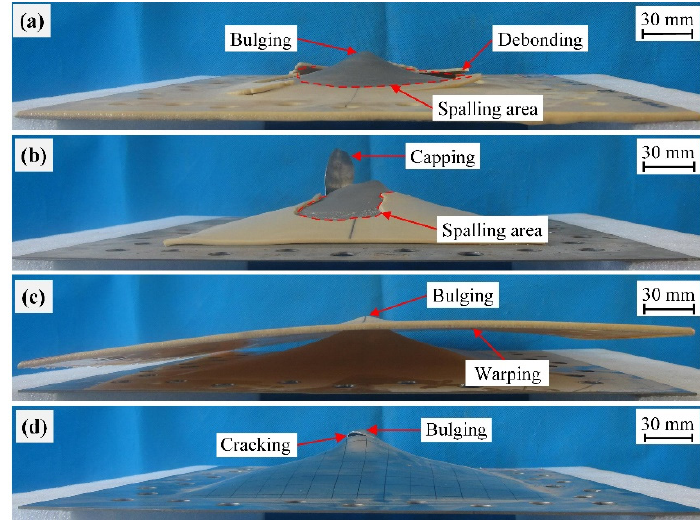
Figure 7. Photographs of the damaged plates ( a ) SPW-2, ( b ) SPP-2, ( c ) SPC-2, and ( d ) BS-2 (from Ref. [47]) tested at a stand-o ff distance of 100 mm.